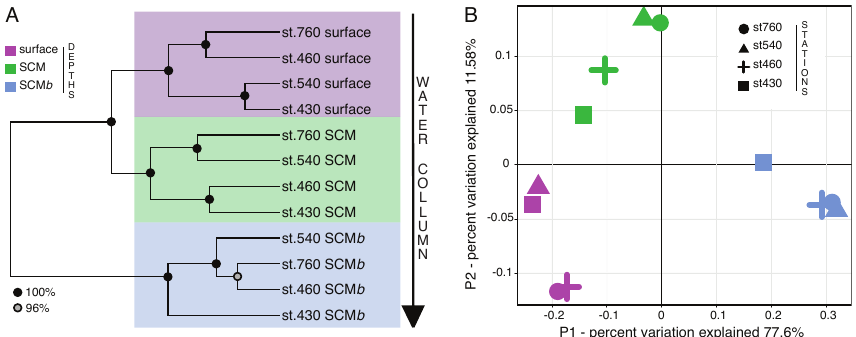
Fig. 2. (A) Weighted Unifrac cluster analysis of HFL OTUs (clustered at ≥ 98% sequence identity). OTU relative abundances were normal- ized across samples. Clustering statistical supports were computed using 100 jackknife replicates. (B) Corresponding principal coordinate analysis (PCoA) using UniFrac weighted distance